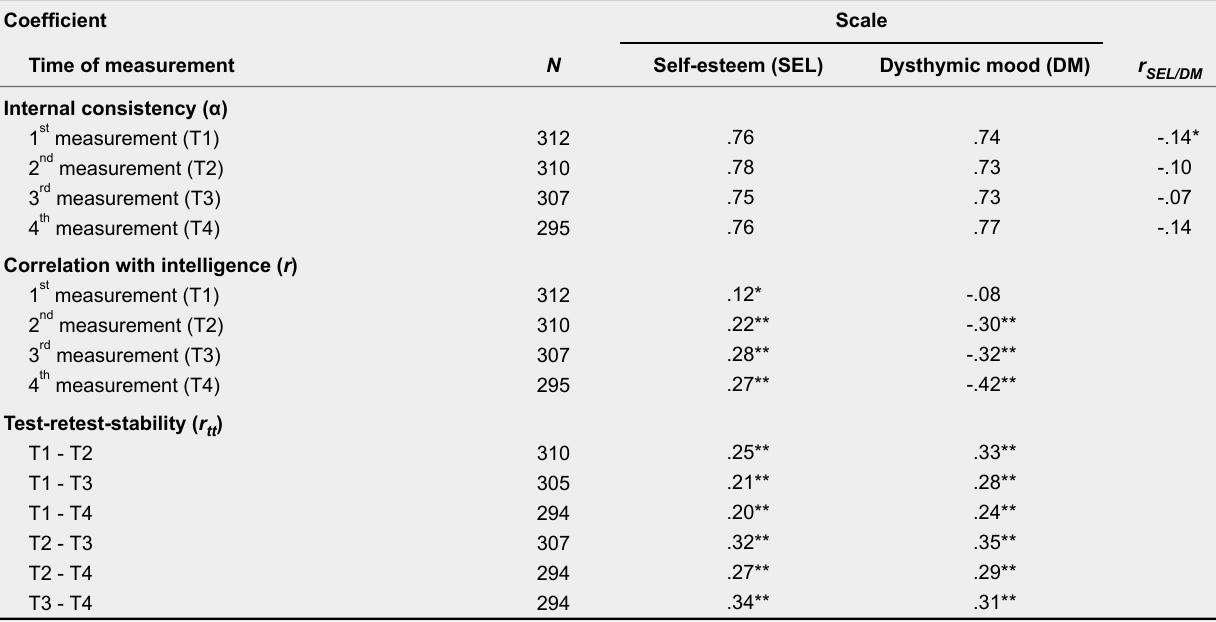
Coefficients of Internal Consistency (Cronbach’s α), Intercorrelations and Correlations With Intelligence of Self-Esteem and Dysthymic Mood at the Four Times of Measurement as Well as Coefficients of Test-Retest Stability Between the Four Times of Measurement in the